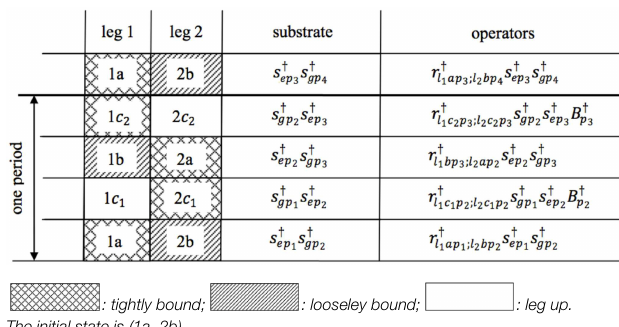
Table 1 subsumes the different individual motion patterns of the two legs of r